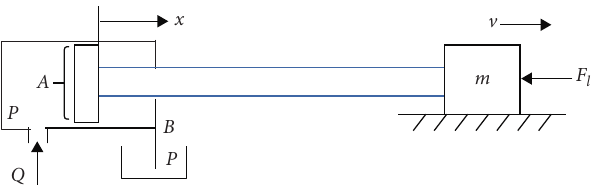
Figure 5: Schematic of hydraulic